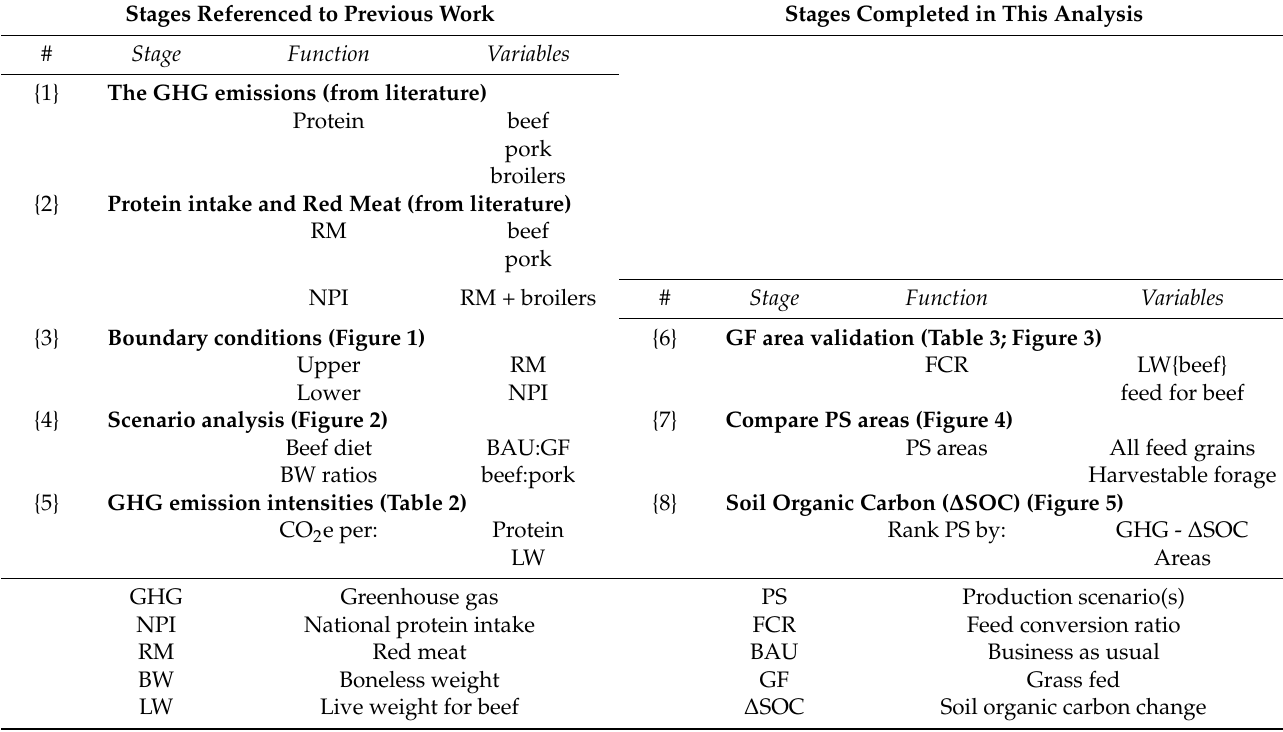
Table 1. Sequence of analytical stages to seek reconciliation of regenerative grazing with reducing livestock GHG emissions in Canada based on reduced red meat consumption and maintaining a constant protein supply to Canadian consumers. Stages Completed in This